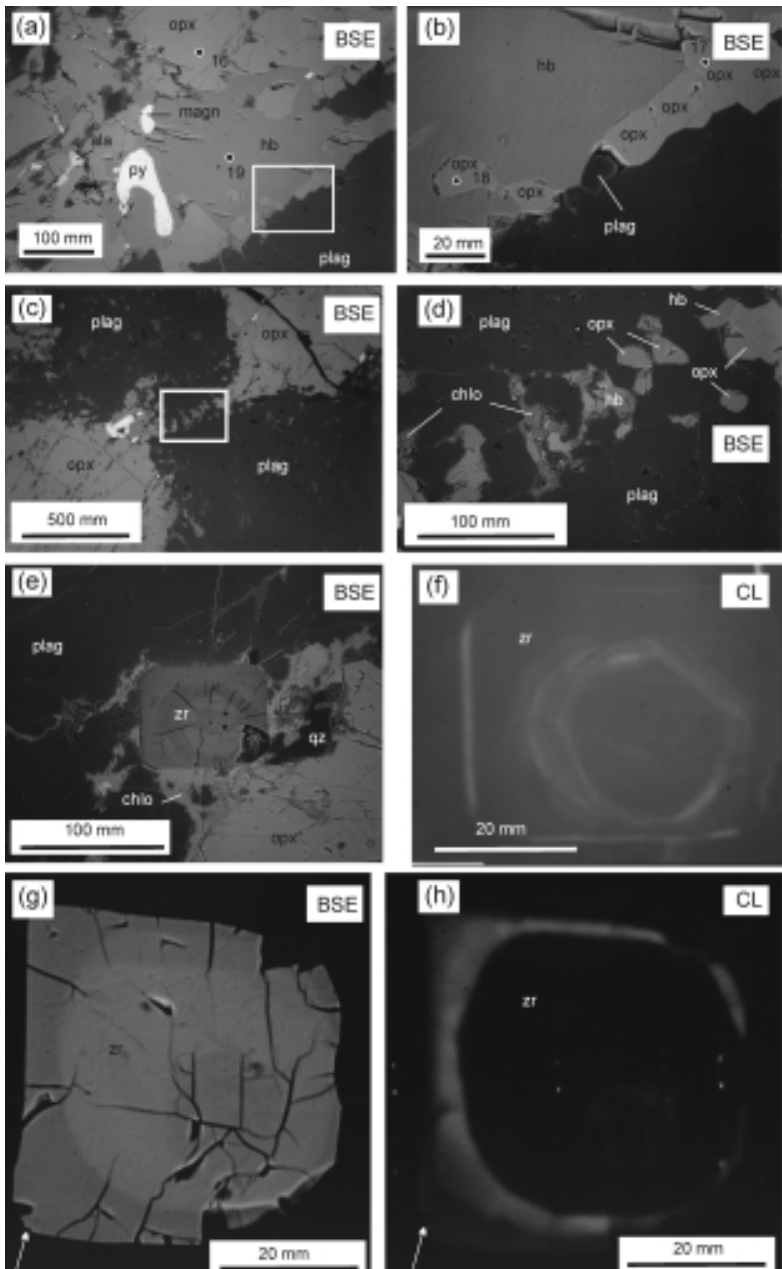
Fig. 5 – Backscattered electrons (BSE) and cathodoluminescence (CL) images from a thin section of the dated sample AL-1. All minerals were identified by electron microprobe. (a)-(d) Numbered spots are locations of chemical analyses by electron microprobe (Table I). Metamorphic M 1 orthopyroxene (large crystals) shown; M 3 orthopyroxene crystals in symplectites also shown. (e) Zircon crystal in intercrystalline position, surrounded in part by chlorite. Zircon has euhedral to subhedral form and some rounding due to metamorphism. (f) Same zircon crystal as Figure (e). Marked diffusional replacement of cores in the two crystals of (e)-(h) and also of rim in (h). Remnant (unsealed) radial fractures seen in preserved magmatic mantle in (e). Arrows in (g) and (h) in same relative position with respect to the crystal rim. An. Acad. Bras. Ci. ,(2000) 72